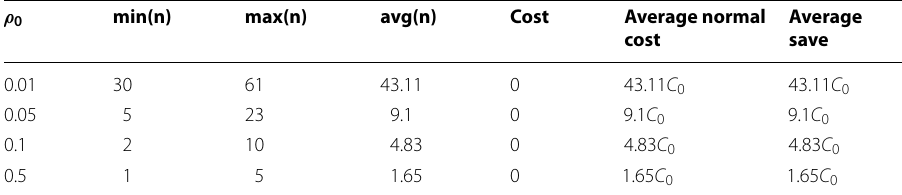
Table 1 The results of the first group of experiments ρ 0 min(n) max(n) avg(n) Cost 0.01